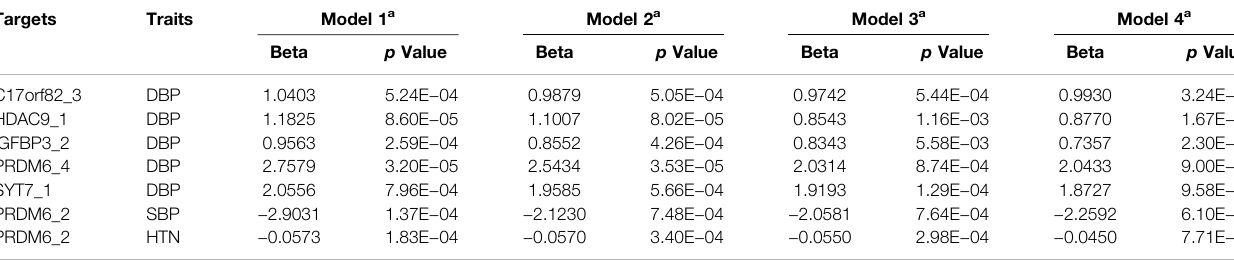
TABLE 4 | The associations between methylation levels and BP and hypertension. Targets